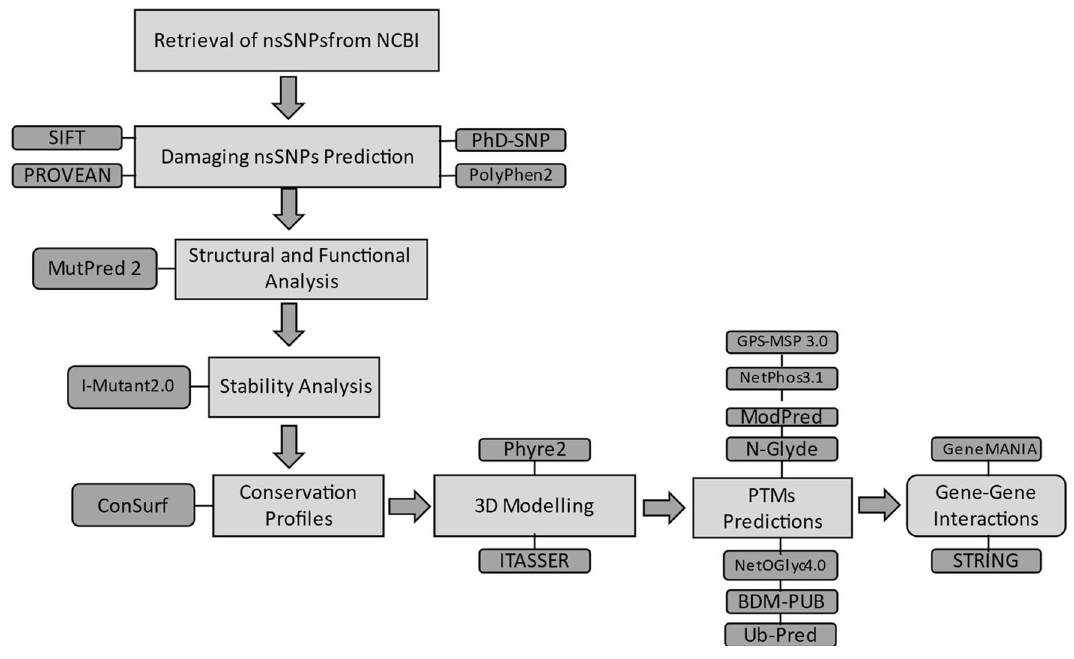
Figure 6. Flowchart representing the methodology of the